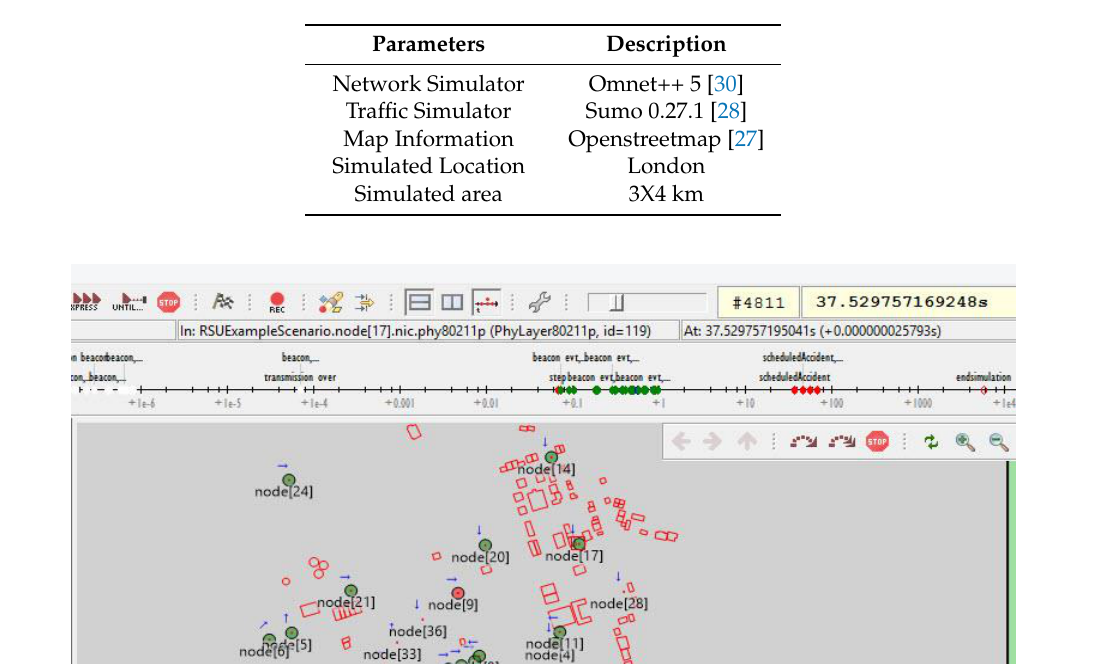
Table 4. Simulation tools.